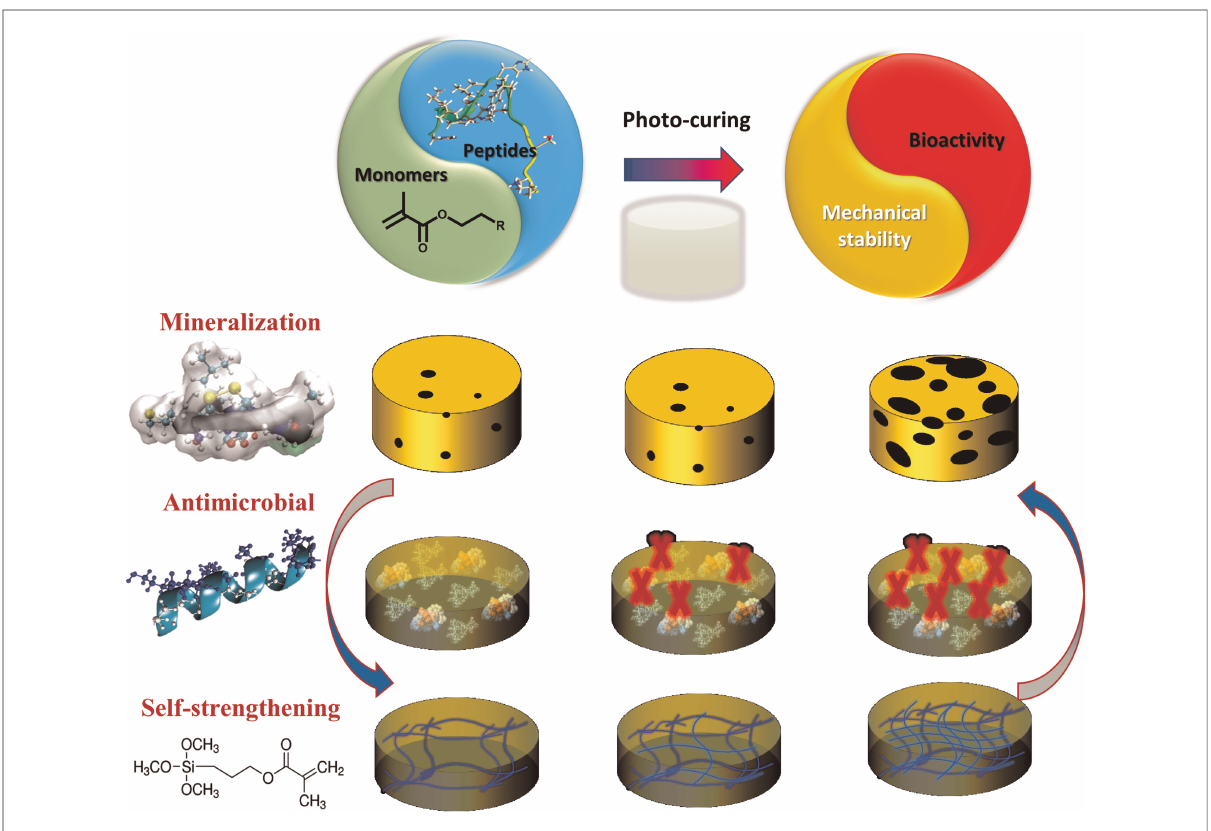
FIGURE 3 Schematic of peptide-polymer hybrid system.